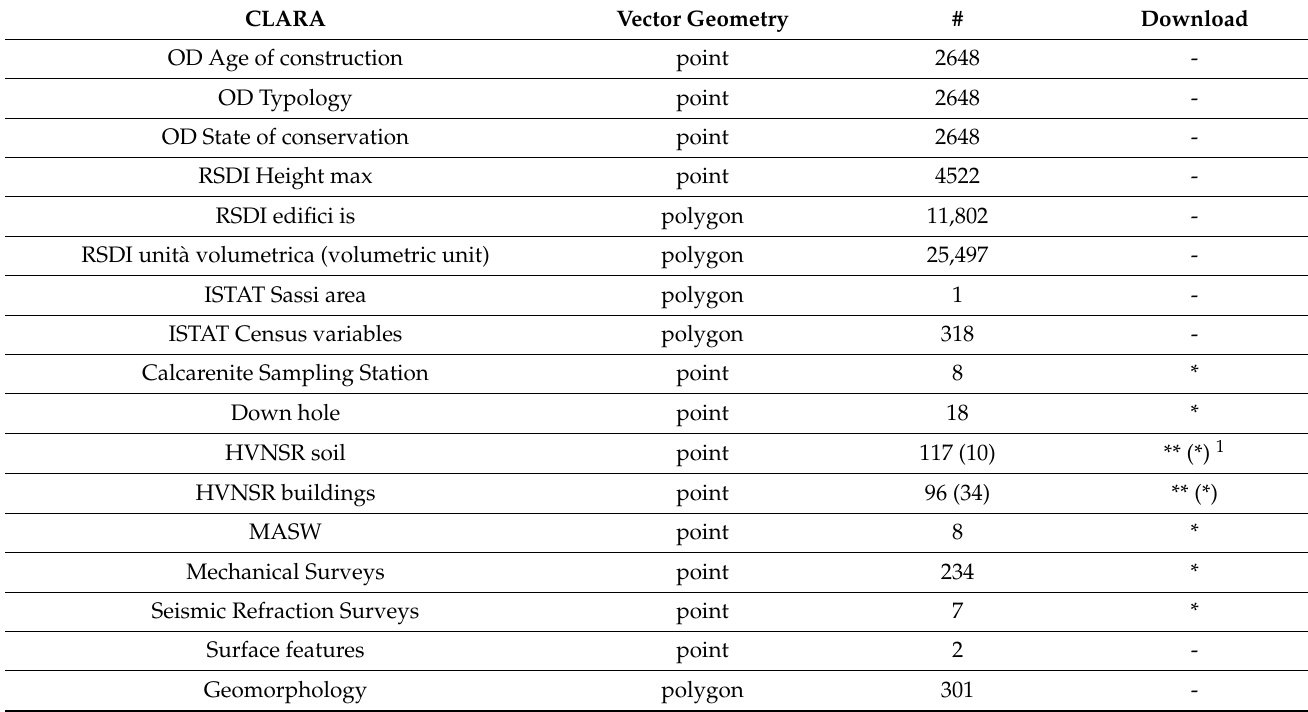
Table 1. Characteristics of all objects present in the CLARA